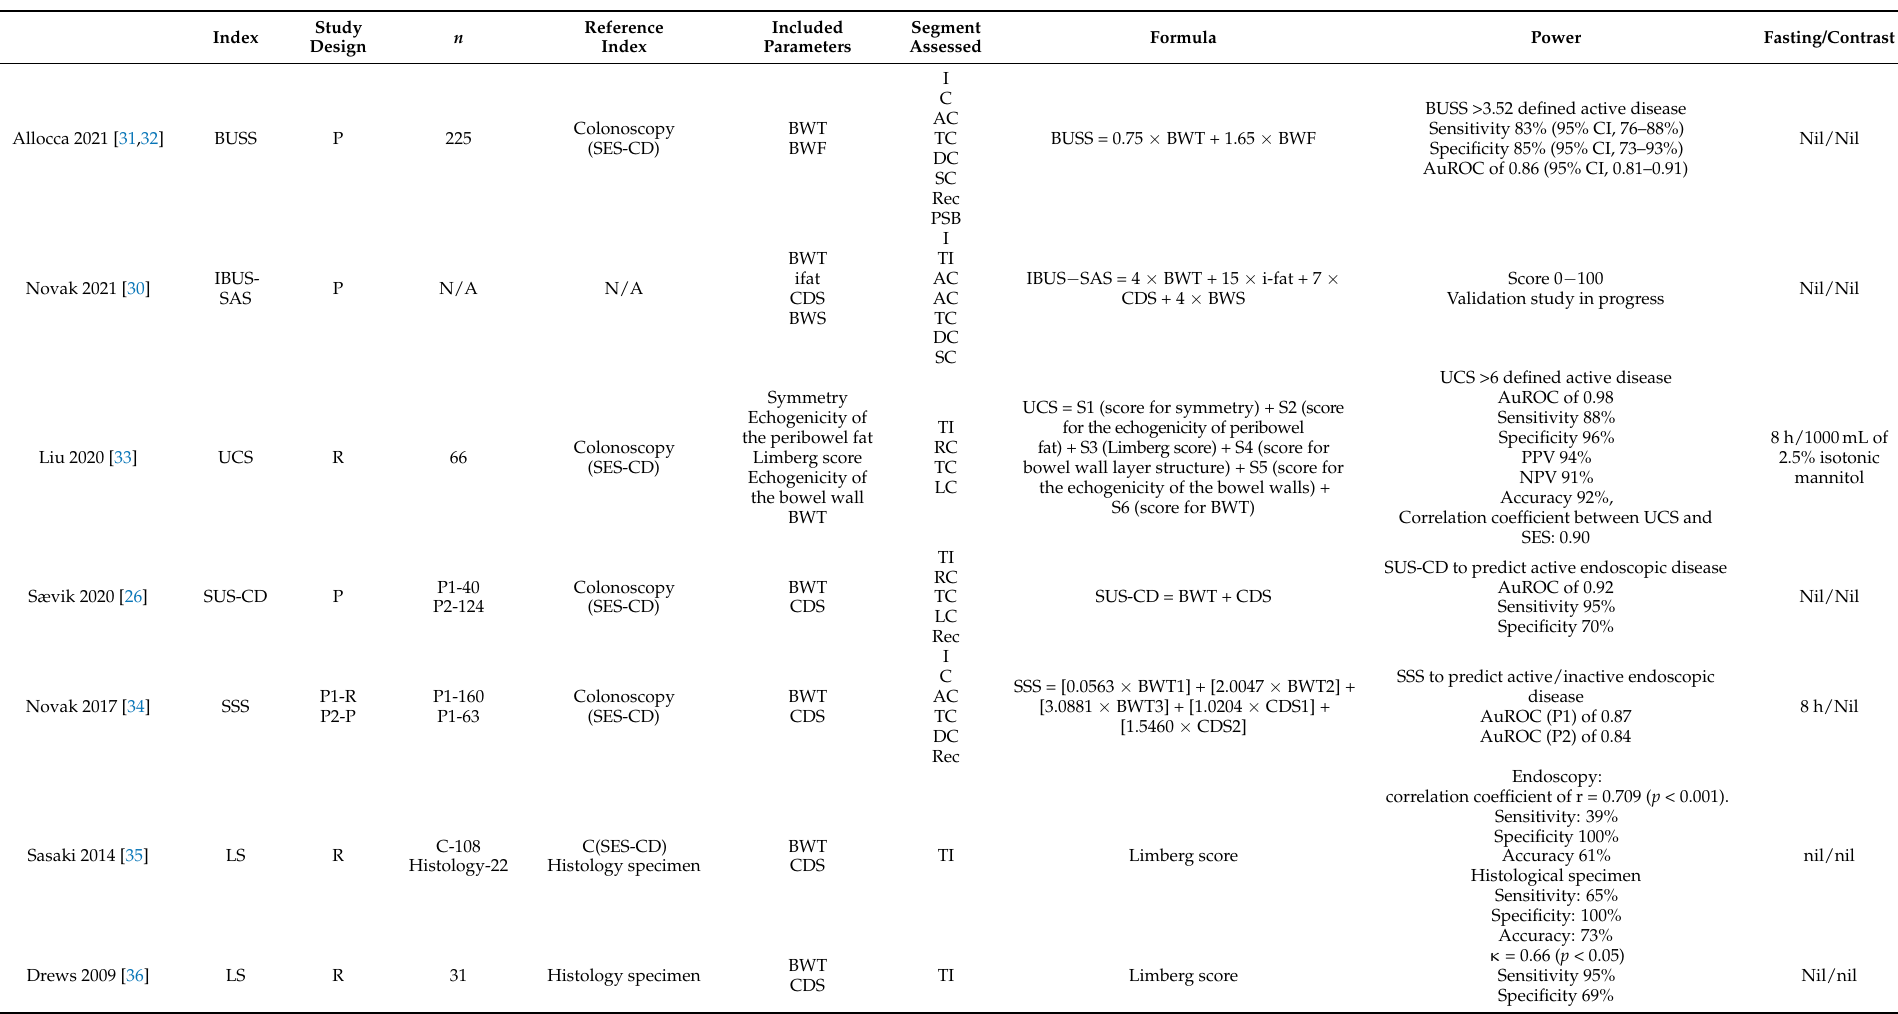
Table 3. IUS indices of activity in